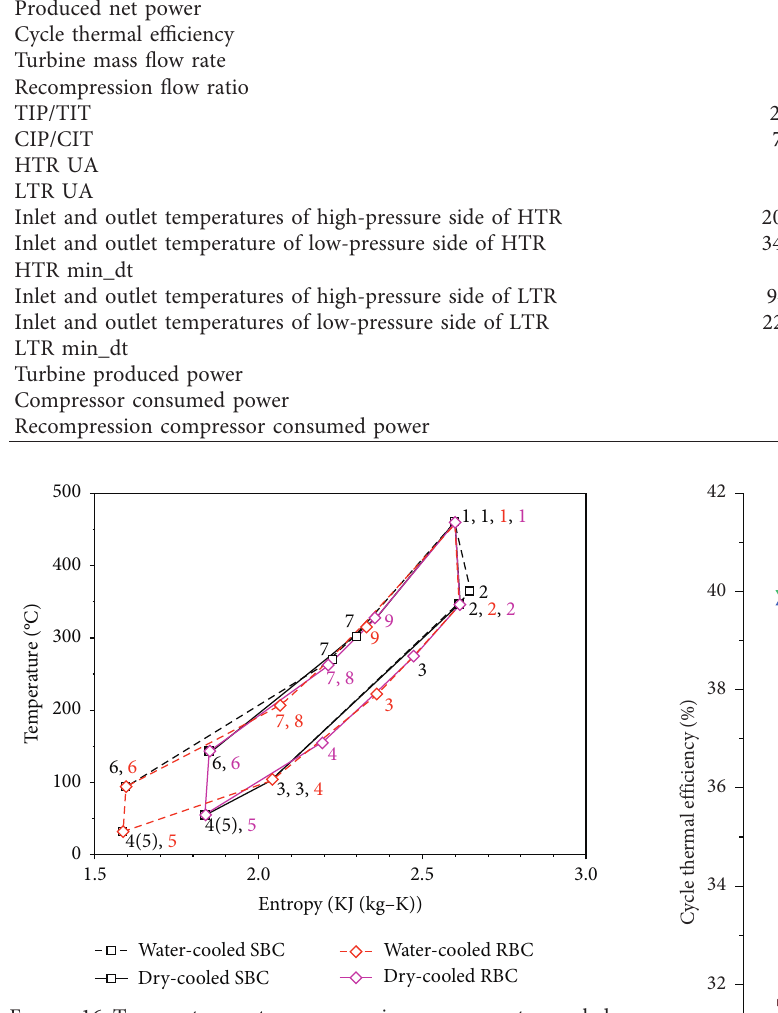
Figure 16: Temperature-entropy comparison among water-cooled and dry-cooled SBC and RBC.